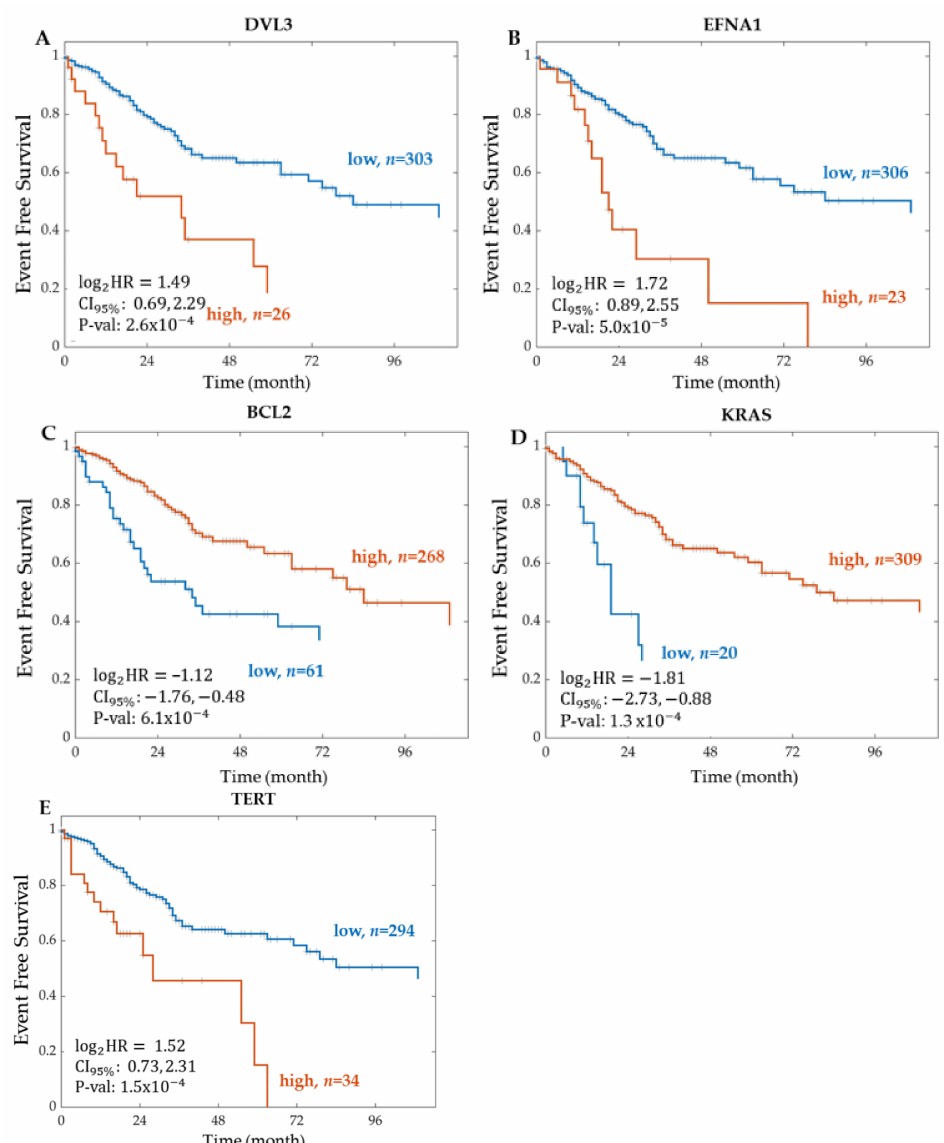
Figure 3. Kaplan–Meier curve of event-free survival for the most significant gene of each CRC STN. The most significant gene in each signalling pathway from the RNA Sequencing TCGA legacy dataset was ( A ) DVL3 for WNT STN, ( B ) EFNA1 for PI3K-Akt STN, ( C ) BCL2 for TP53 STN, ( D ) KRAS for MAPK STN, and ( E ) TERT for TGF-Beta STN. The patients were stratified into two groups according to the expression level of each feature. The optimal cut-off was determined using Kaplan–Meier scanning (see Methods). The groups are represented as high (orange line), and low (blue line), where n indicates the total number of patients in each group. For each group, the Kaplan–Meier curve of event-free survival was tested for statistically significant differences using a log-rank test. Log HR = log base 2 of the hazard ratio. CI 95% = 95% Confidence Interval. P-val = p 2